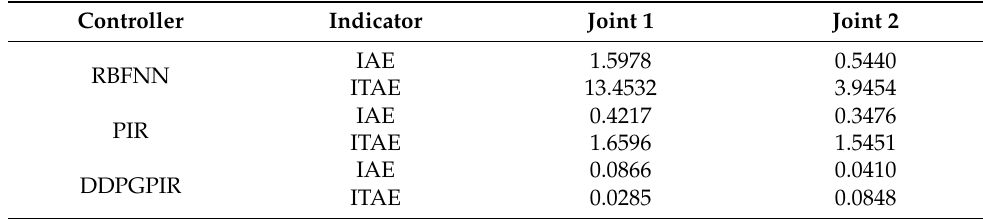
Table 1. Performance index calculation